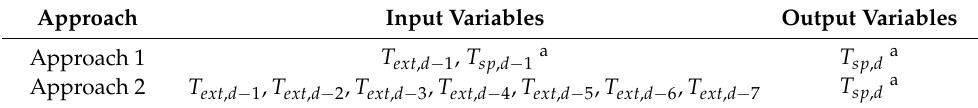
Table 5. Input and output variables for each